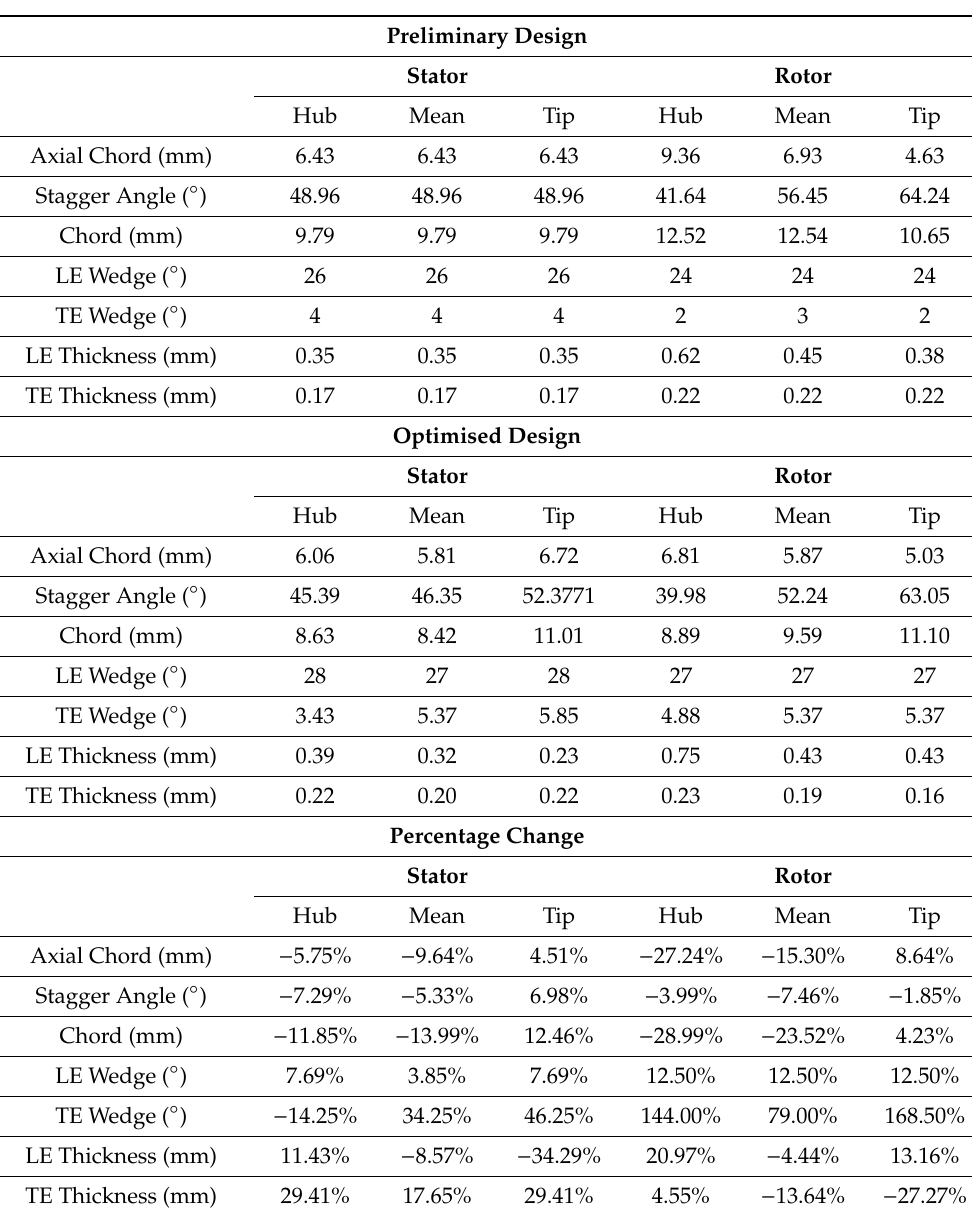
Table 5. Comparison between preliminary parameters and optimised